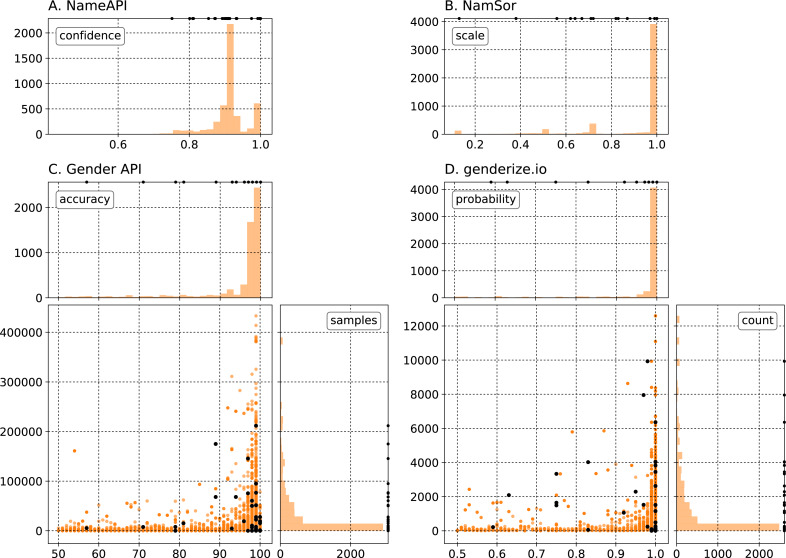
Distribution of free parameters after querying the gender inference services with all f/m names from our test data set.(A) and (B) return one parameter, while (C) and (D) return two. In black, a particular instantiation of the grid of parameters per service used to perform parameter tuning is shown.